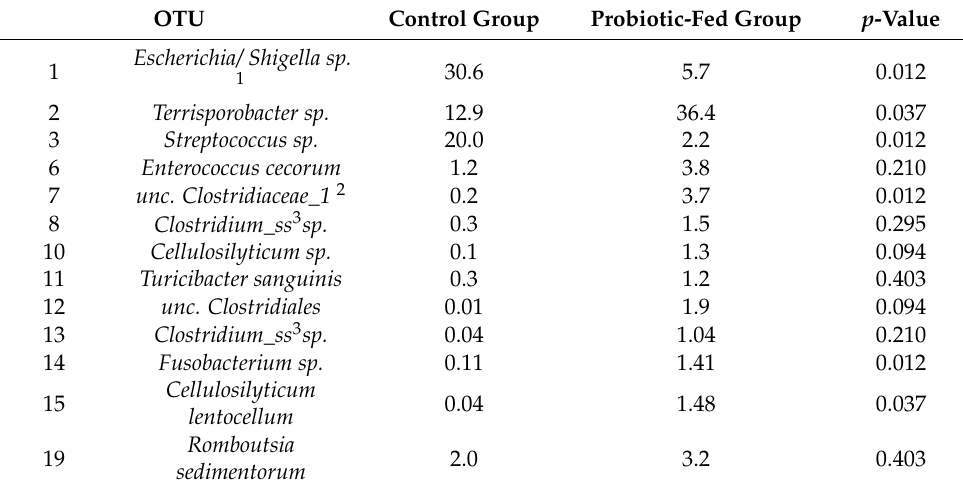
Table 2. Relative abundance (%) of bacterial OTUs, dominant in the fecal assemblages of ducks of the control and/or probiotic-fed